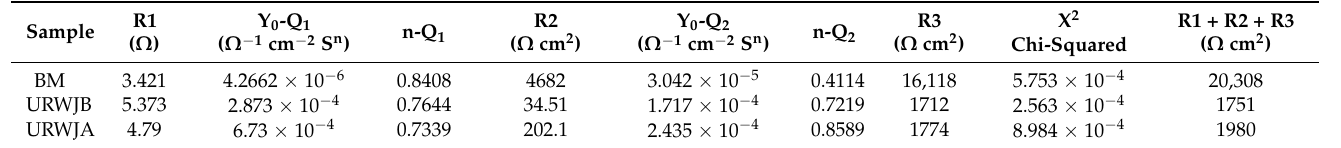
Table 5. Equivalent circuit element values of EIS test corresponding to URWJs by FBW.